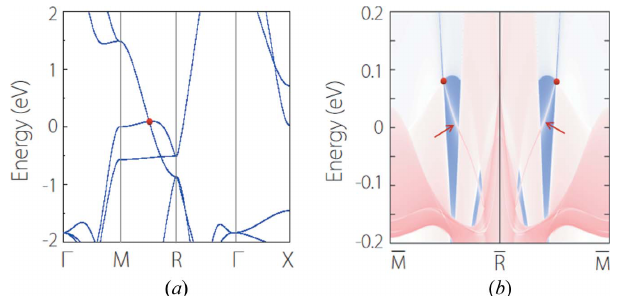
Figure 4 Identified TMs with coexisting nodal line and triple nodal point. The energy positions of band crossing for the triple nodal point and nodal line are shown with orange circles and green squares, respectively.